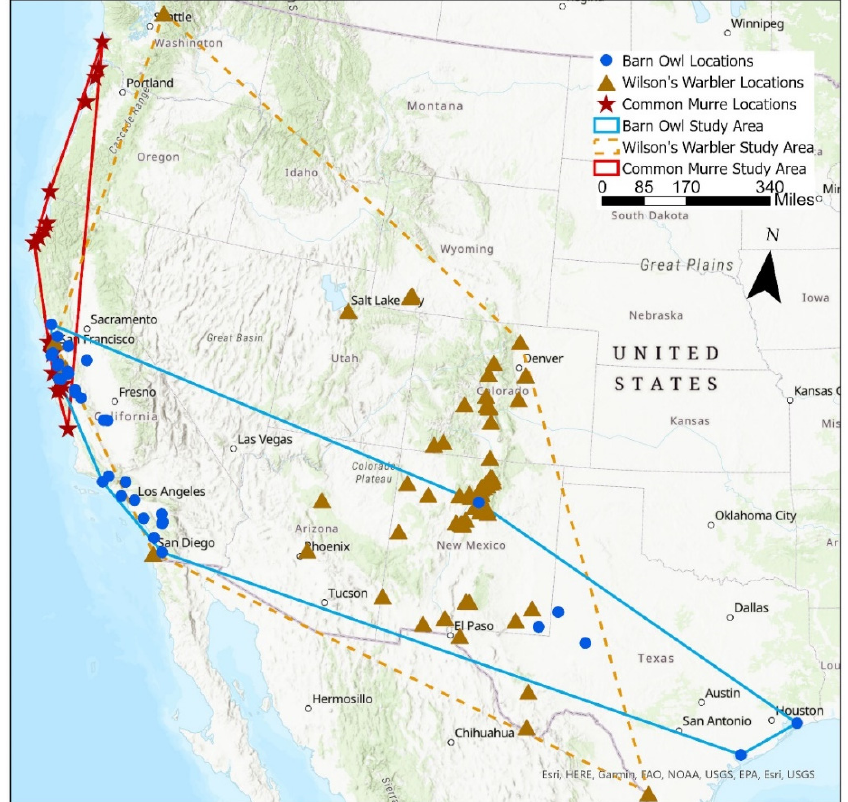
Figure 1. Citizen science observations for the mortality of Wilson’s Warbler (triangle), Barn Owl (circle), and Common Murre (star) in the western and central United States in 2020. Each symbol may represent multiple carcasses.